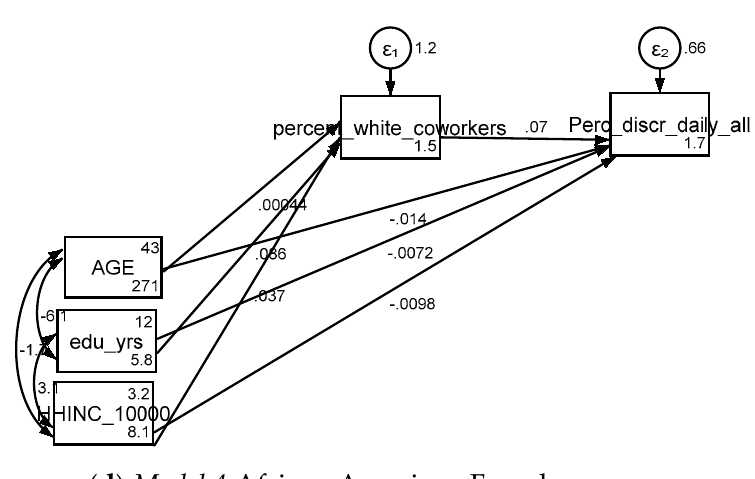
Figure 1. Summary of path model on the associations between socioeconomic status (household income and educational attainment), racial composition of workplace and perceived discrimination in employed African American men and women. ( a ) Model 1 Pooled sample without mediator; ( b ) Model 2 Pooled sample with mediator; ( c ) Model 3 African American Males; ( d ) Model 4 African American Females. Notes: Outcome: Discrimination (Everyday), Independent variables treated as continuous measures, Household income measured as 1) 0 – 9999 USD, 2)10,000 USD – 19,999 USD, 3) 20,000 USD – 39,999 USD and 4) 40,000 USD or more. Educational attainment measured as 1) equal or